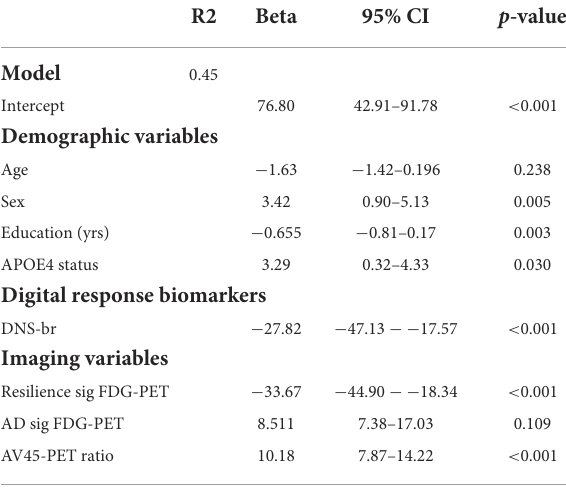
TABLE 5 Results of the linear multiple regression models to predict impairment of your global cognition in the 80 + participants Beta coefficients, confidence intervals (CI) for unstandardized Betas and p -values are provided.